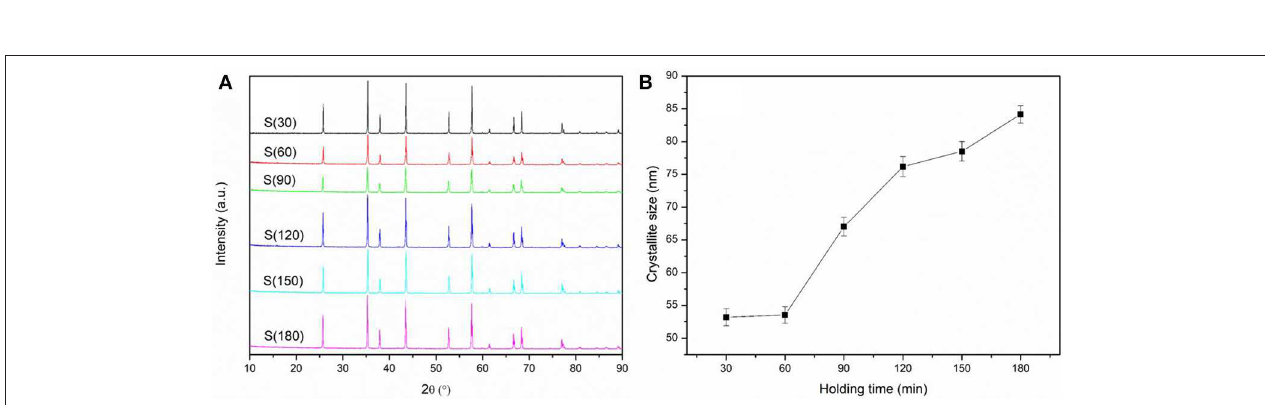
FIGURE 8 | XRD results of alumina ceramic sintered with different holding times: (A) The XRD curves and (B) The crystallite size.